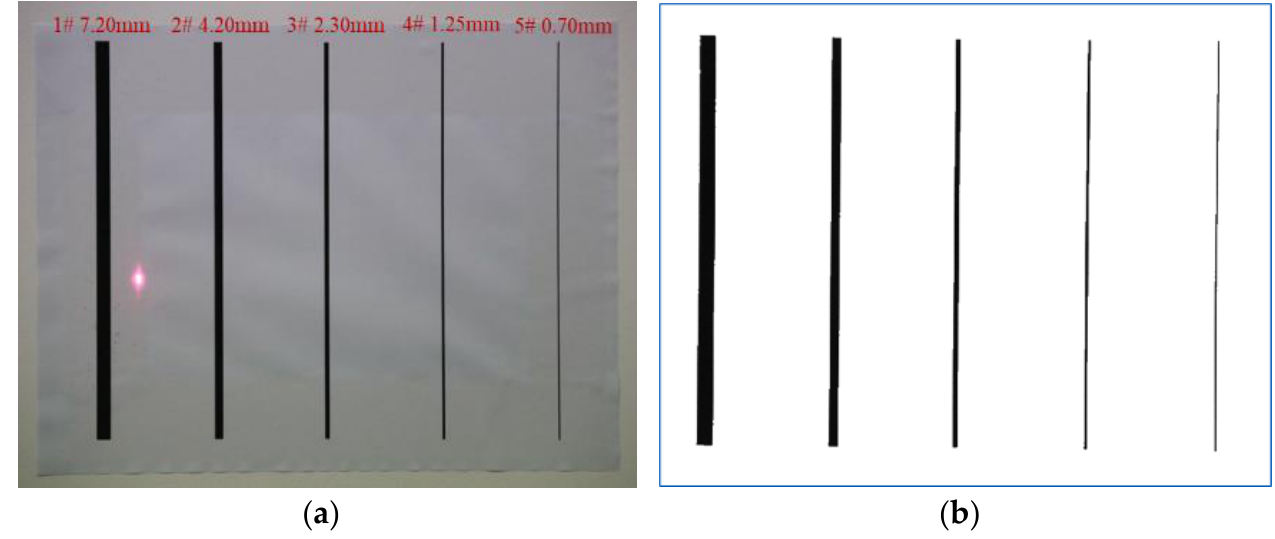
Figure 18. Five artificial cracks: ( a ) original image with measured width; ( b ) segmentation results of